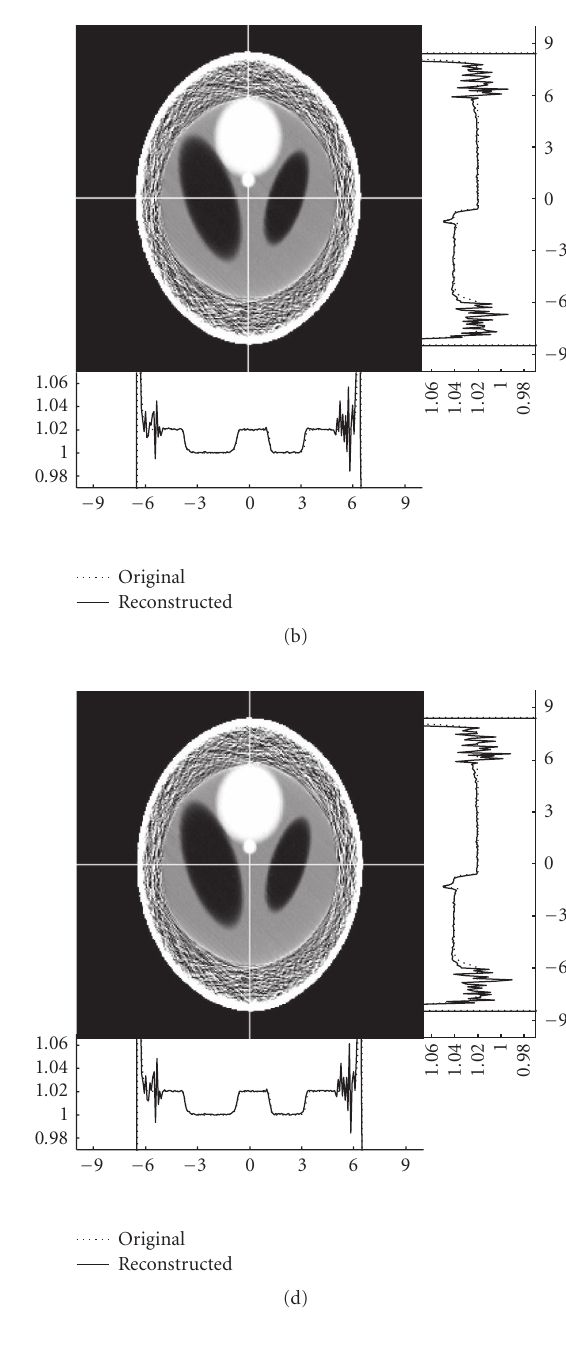
Figure 4: Typical reconstructed images of the DSLP from data collected along a nonstandard saddle curve with a display window [1 . 0,1 . 04]. The top slices were reconstructed by the FBP method, while the bottom slices were reconstructed by the BPF method. The left and right slices are at X = 0cm and Z = − 2 . 5 cm, respectively. The two profiles along the white lines are plotted for each slice. The dotted and solid curves represent the original and reconstructed